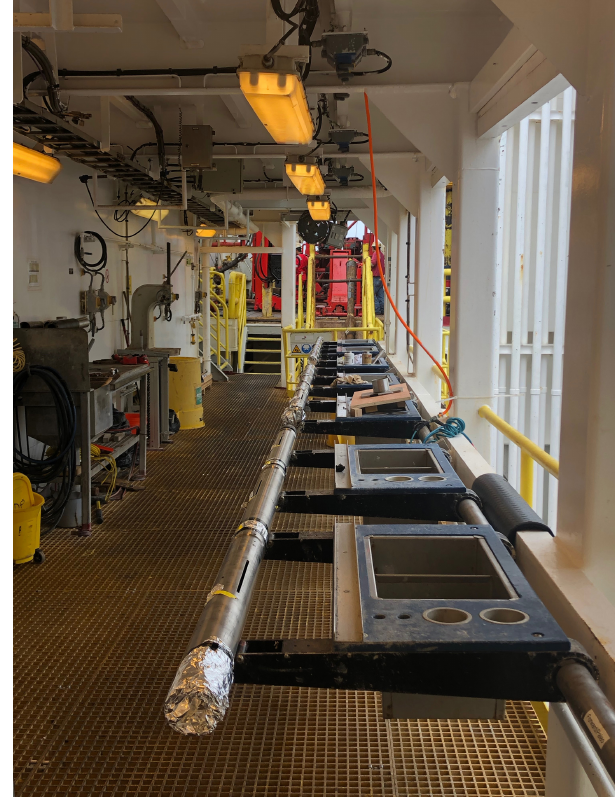
Figure 3. A total of 11 modules were combined in three section on the catwalk in anticipation for deployment within DSDP Hole 504B on IODP Expedition 385T in August 2019 (Tominaga et al., 2019). Final assembly and connection to other sensing instruments would occur on the rig floor, which is up the four steps at the end of the catwalk. Aseptic aluminum foil covers the fluid intake to minimize microbial contamination prior to